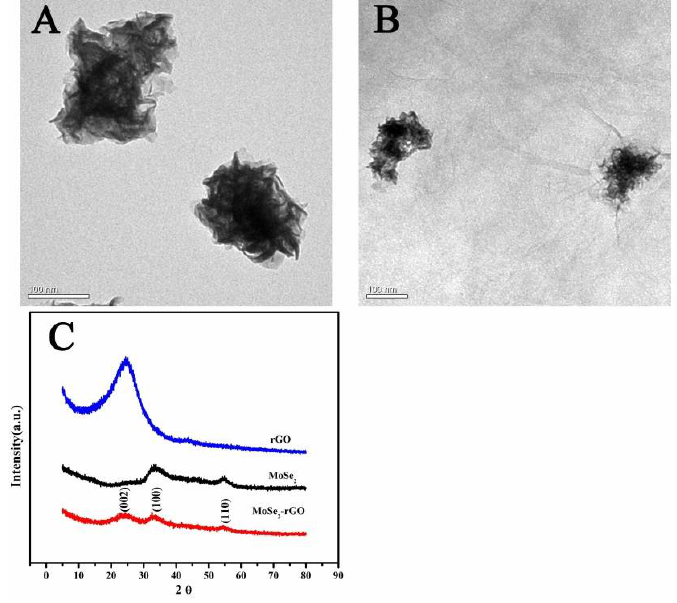
Figure 1. Characterization of the prepared electrode materials. ( A ) TEM images of MoSe 2 nanoparticles; ( B ) TEM images of the MoSe 2 /rGO composite; and ( C ) XRD spectrum of the rGO, MoSe 2 and MoSe 2 /rGO